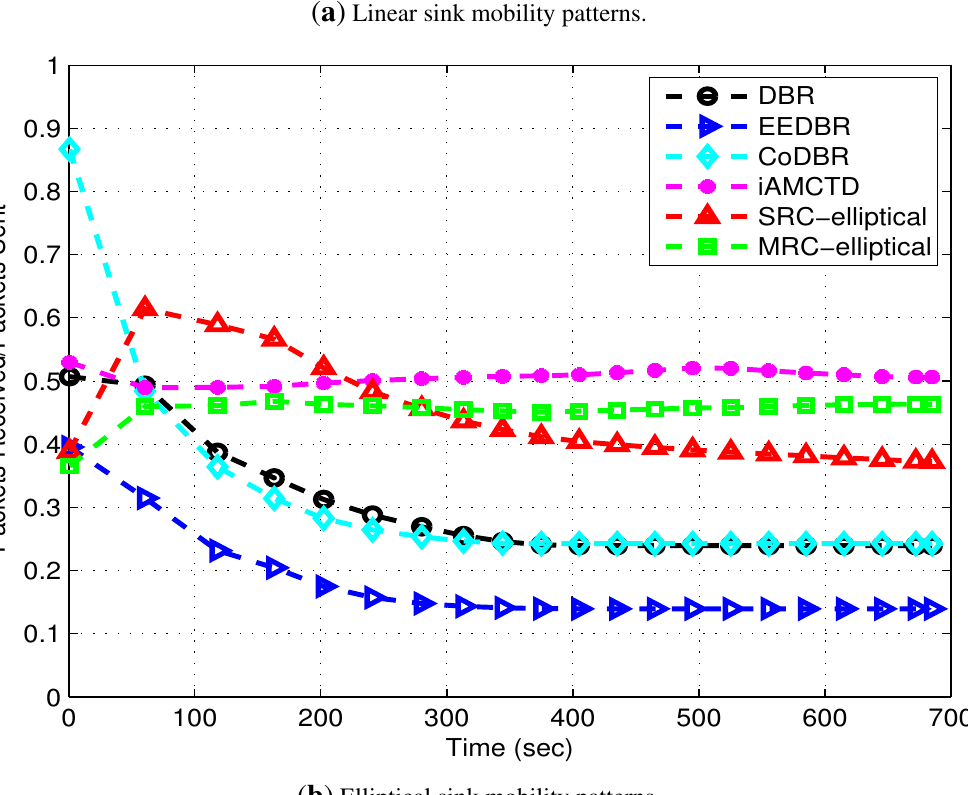
Figure 14. PAR attained in the networks with linear and elliptical sink mobility patterns.